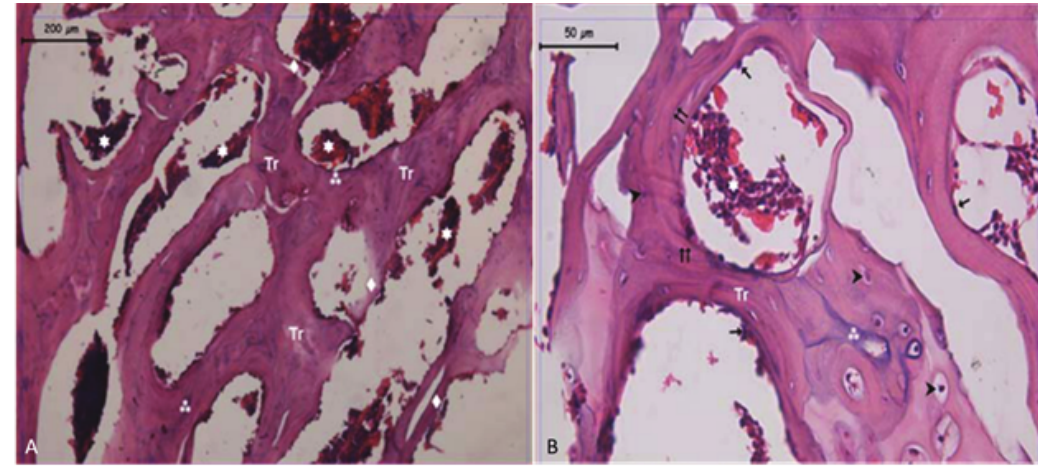
Figure 2: Microscopic view of the femoral neck in the diabetic group without therapy. Tr: trabeculae; *Bone marrow tissue; ◊ Irregular bone trabeculae; Basophilic bone sites. Arrowhead: Osteocyte; Arrow: Osteoblast